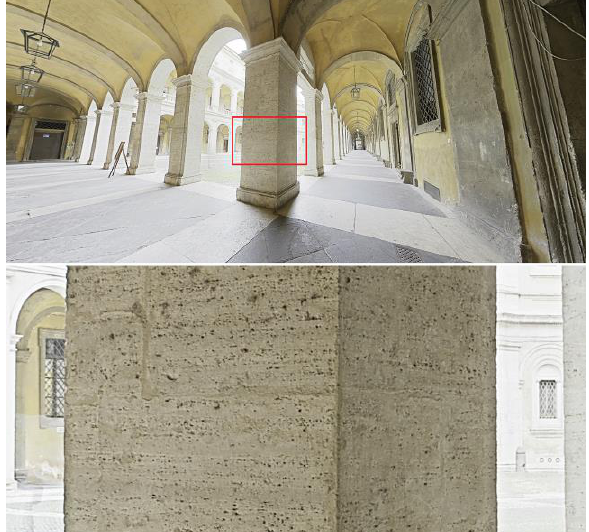
Figure 4. The SW angle span Virtual Tour tight zoom factor The following sets were applied on some spans at intrados, along the portico at ground floor, two at SW and NW (angle spans), one at W (central span) of building. The shooting used the identical settings as before said, but being the camera centred inside of each span measuring 6x4m, so near to the wall, any image reached a high pixel resolution. These pictures, taken at 3m distance, reached a scale of 1:7.45, getting 740 pixels in 1.10m, one pixel corresponding